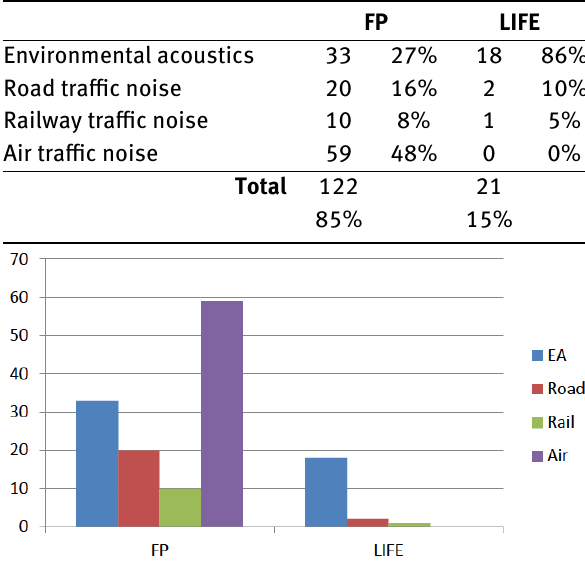
Figure 2: Distribution of research topic within financing pro- grammes (number of